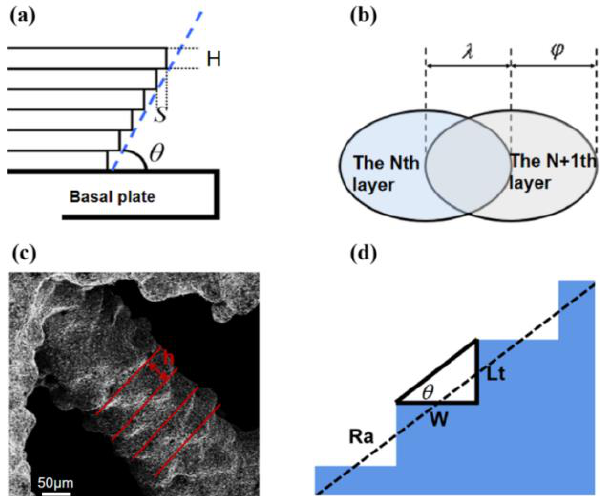
Figure 3. Schematic diagram of slicing and layered built-up structure by L-PBF: ( a ) slice of the outer surface of the inclined part; ( b ) overlapping region of the adjacent molten tracks; ( c ) layered height of the as-printed micro-rod; ( d ) the geometric relation between surface roughness, Ra, and the outer surface “ steps ” .